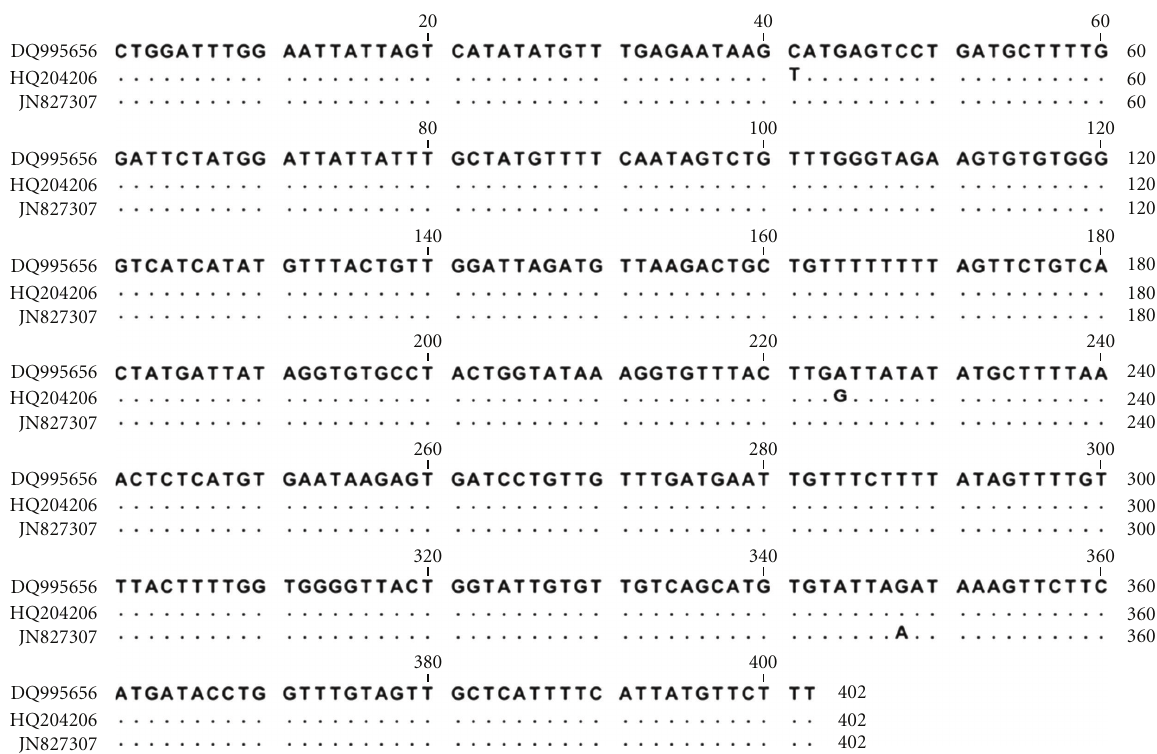
Figure 4: Nucleotide sequences of partial mt-CO1 for T. hydatigena analyzed in this study (JN827307) aligned with the published (DQ995656, HQ204206) mt-CO1 sequences of the T. hydatigena as a reference. A dot indicates a nucleotide that is conserved relative to the published